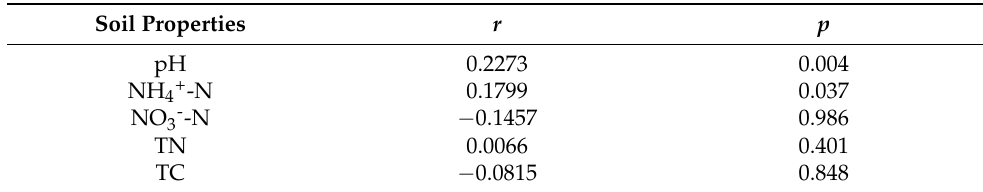
Table 2. Correlations among the overall bacterial community structure and soil proprieties according to the Mantel